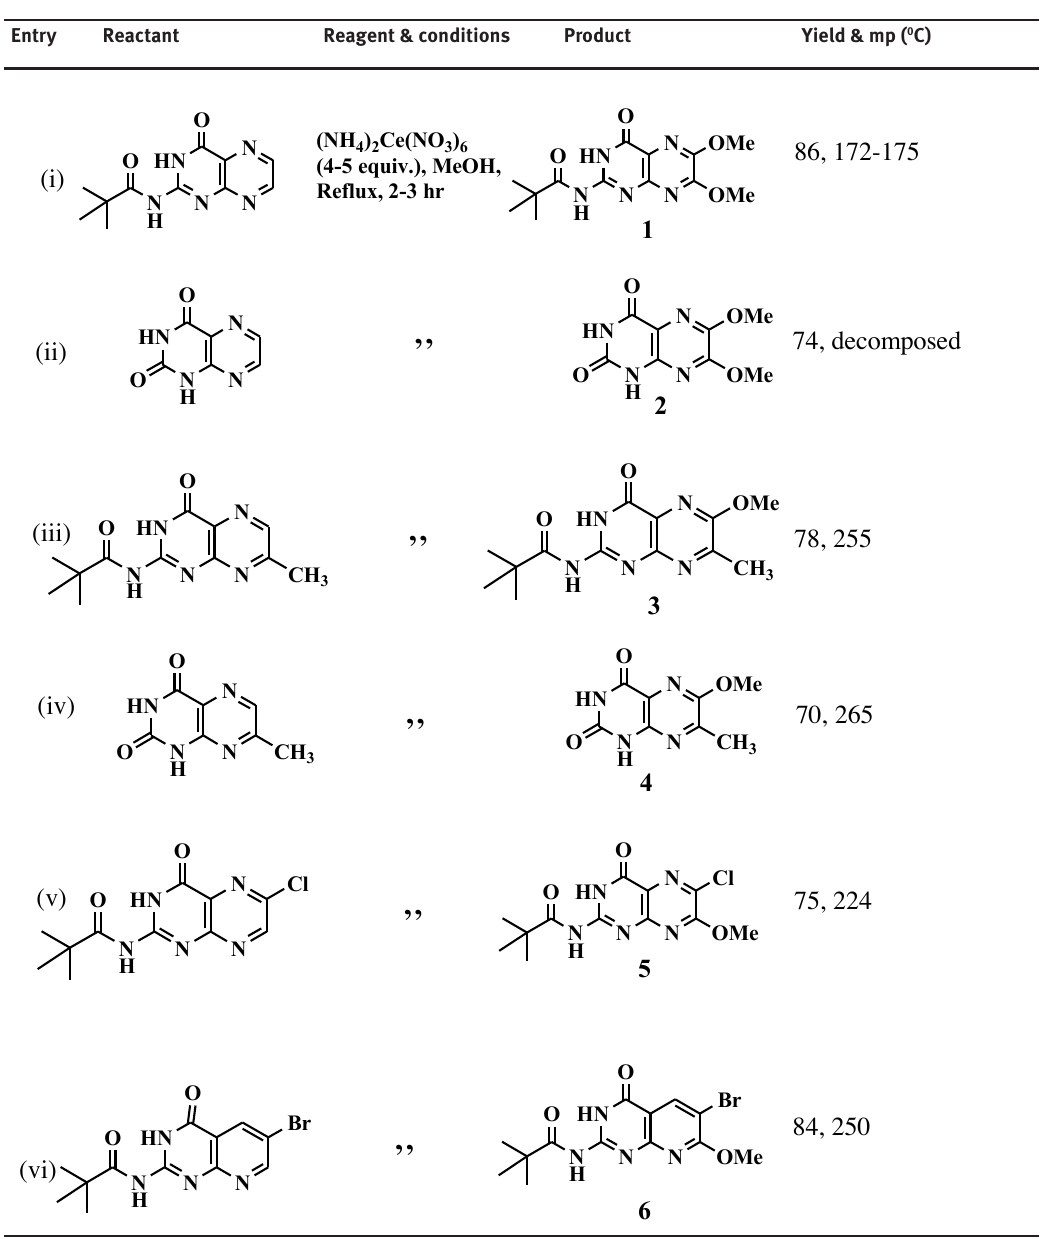
Table 1: Methoxylation of pterin at 6,7 position using methanol.